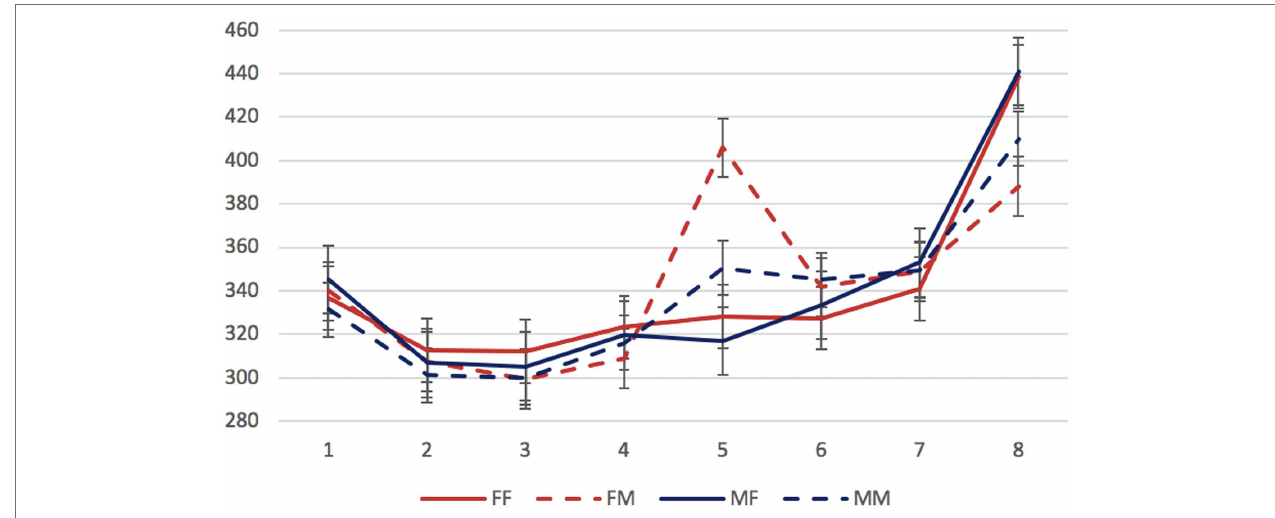
FIGURE 1 | Experiment 1, the syncretic inanimate dependent group: mean RTs per region (in ms) in the four experimental conditions. Regions: N 1 (head)— preposition—N